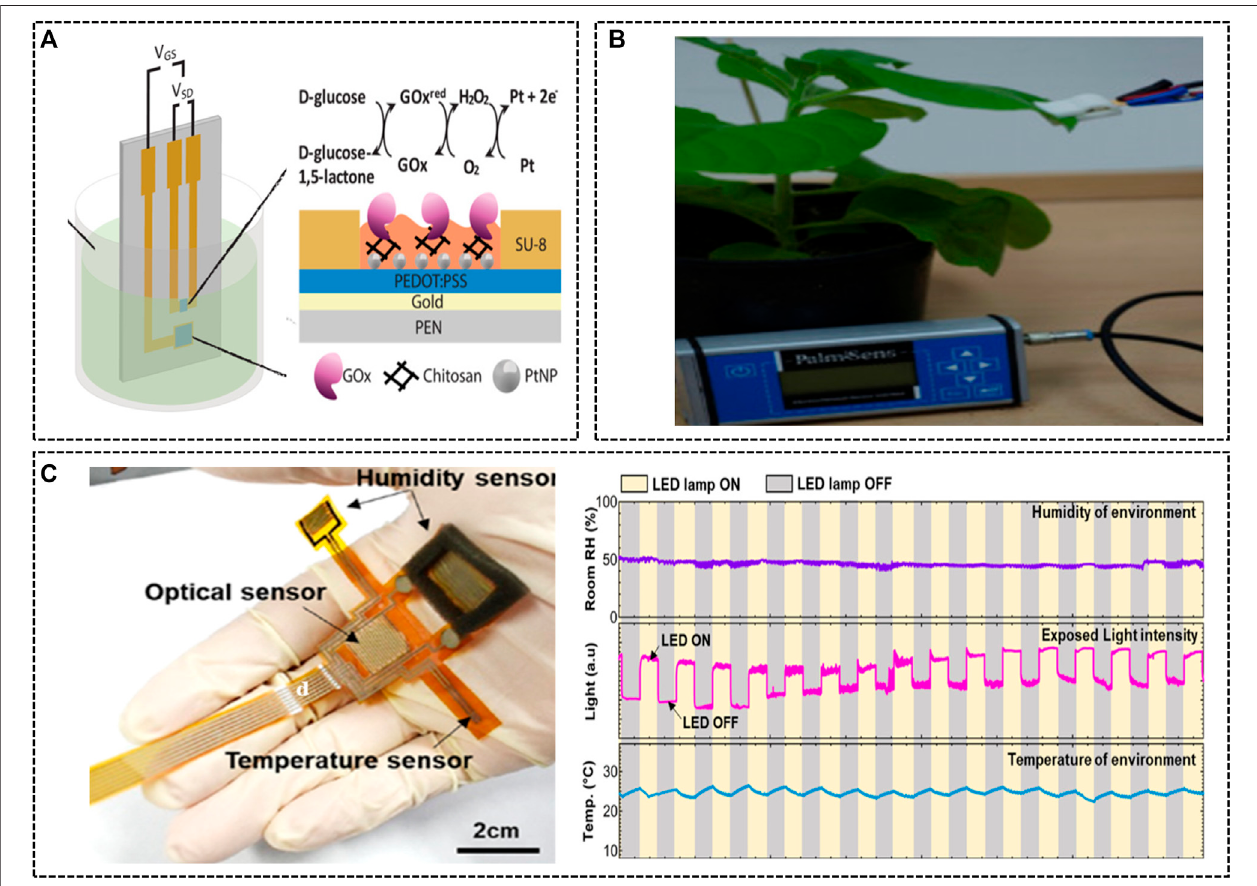
FIGURE 6 | Electrochemical plant sensors. (A) Overview of the experimental design for the detection of glucose in isolated chloroplasts (Diacci et al., 2020). Copyright © 2020(Wiley-VCH). (B) A3D-printedchipholdercontainingahand-heldpotentiostatandsensorchip(Pandeyetal.,2018).Copyright © 2018(Elsevier). (C) A multimodal fl exible plant sensor integrated with humidity, optical, and temperature sensors (left) and thee results of transpiration monitoring using a multimodal fl exible sensor device for over 350 h (right) (Lu et al., 2020). Copyright © 2020 (American Chemical Society).